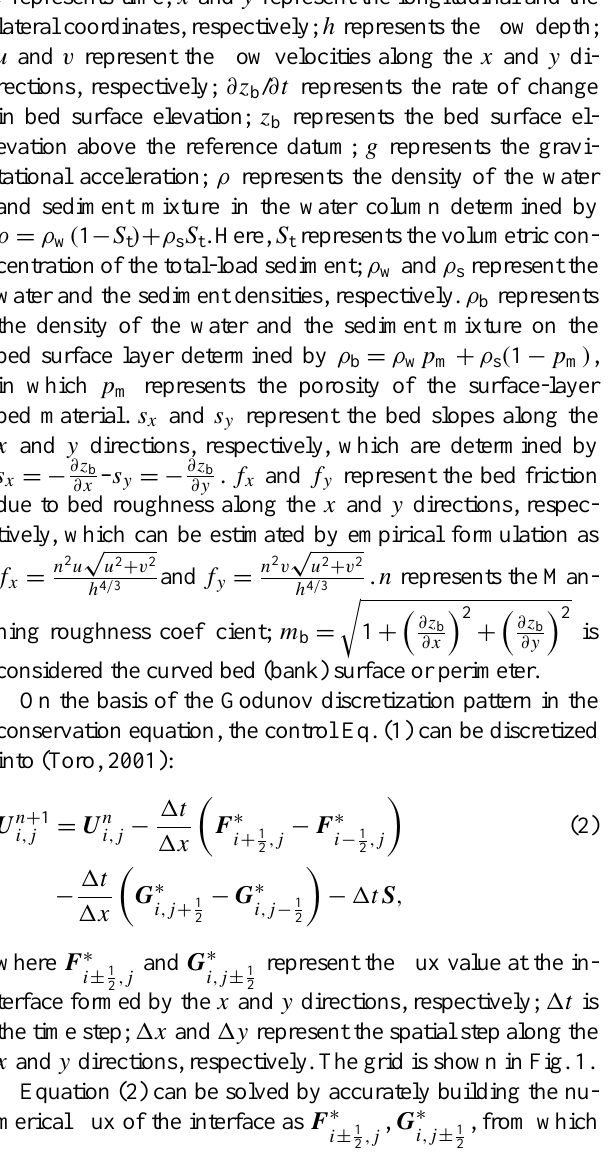
Fig. 1. Solution Fig. 1 Solution grid.